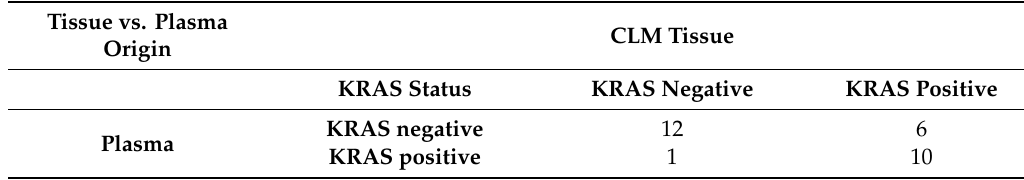
Table 2. The concordance between tissue KRAS status (KRAS positive vs. KRAS negative) in colorectal cancer liver metastases (CLM) and preoperative plasma samples (Plasma). Tissue vs.